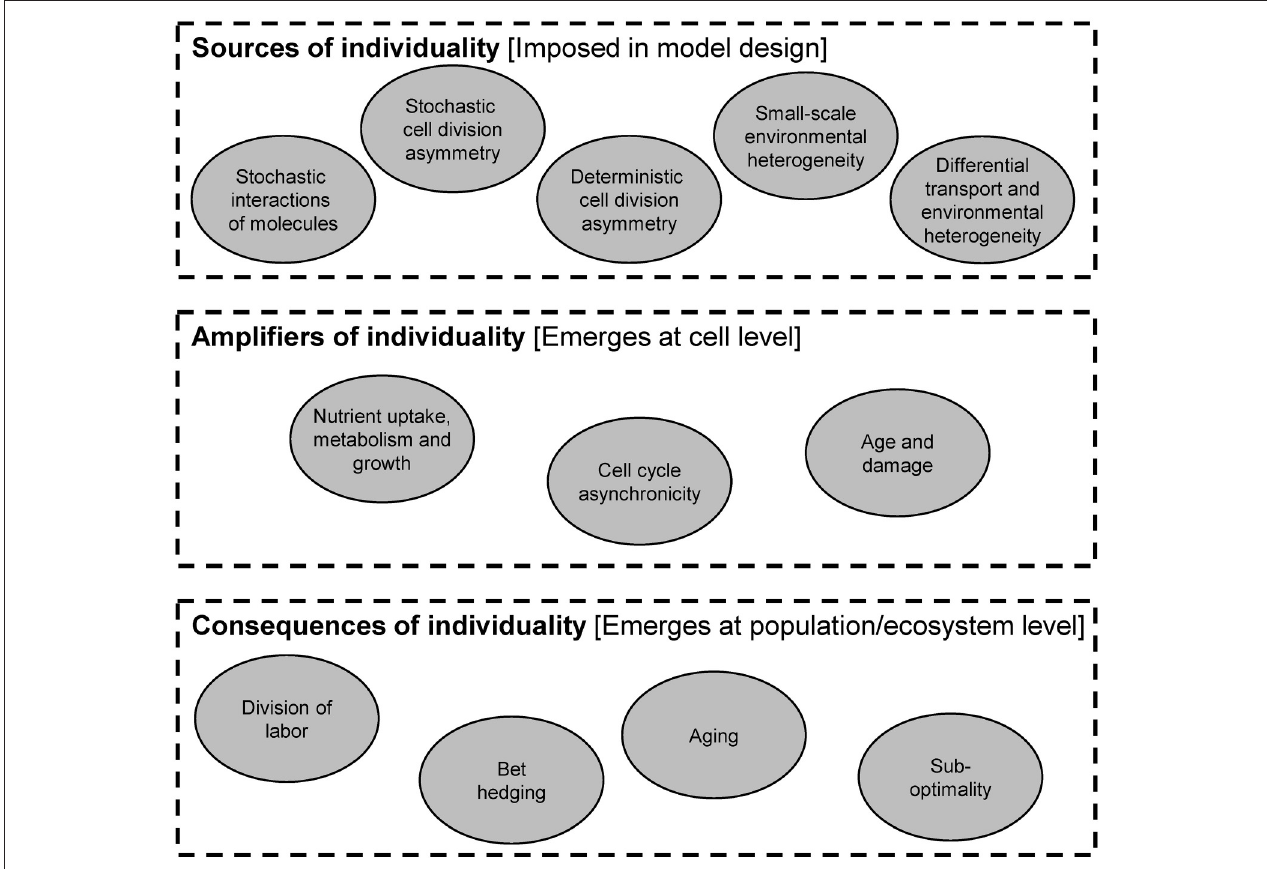
FIGURE 6 | Sources, amplifiers and consequences of individual heterogeneity.